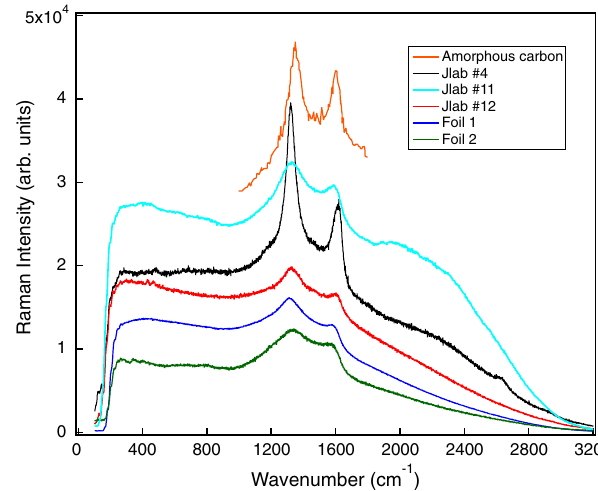
FIG. 7. Raman spectra taken from cold-worked Nb foils and Jlab hot spots in comparison with spectrum from amorphous carbon [37]. Foils 1 and 2 are from Alpha Aesar that have been annealed to the melting point in UHV and subsequently cold worked in air as described in the text. The legend shows the order of the spectra based on height of the 1300 cm (cid:3) 1 peak.